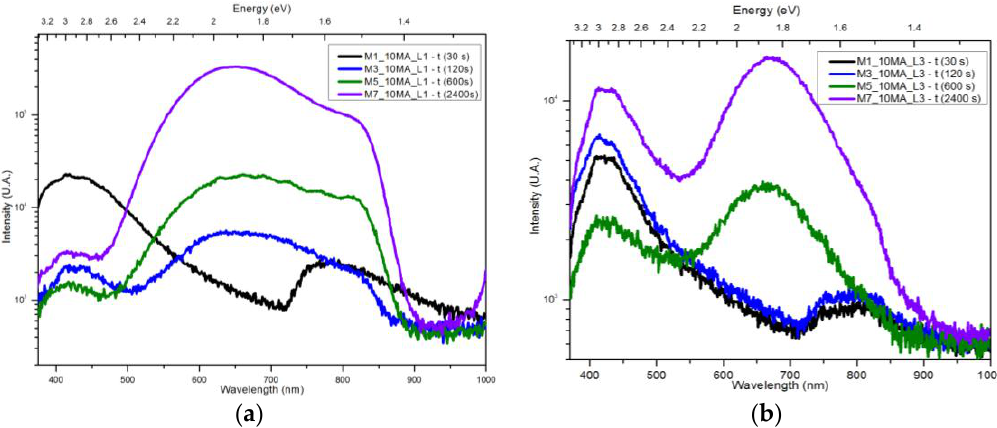
Figure 6. ( a ) Photoluminescence spectra of porous silicon layers synthesized with 10 mA current for different anodizing times ( a ) without MWCNT’s and ( b ) with